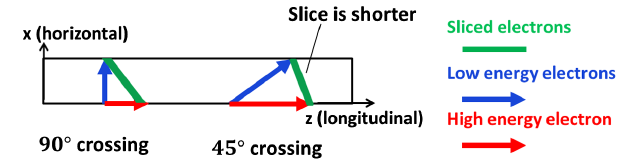
FIG. 9. Pase space for y 0 versus z at the crossing point at 8.3 m right after the kick.